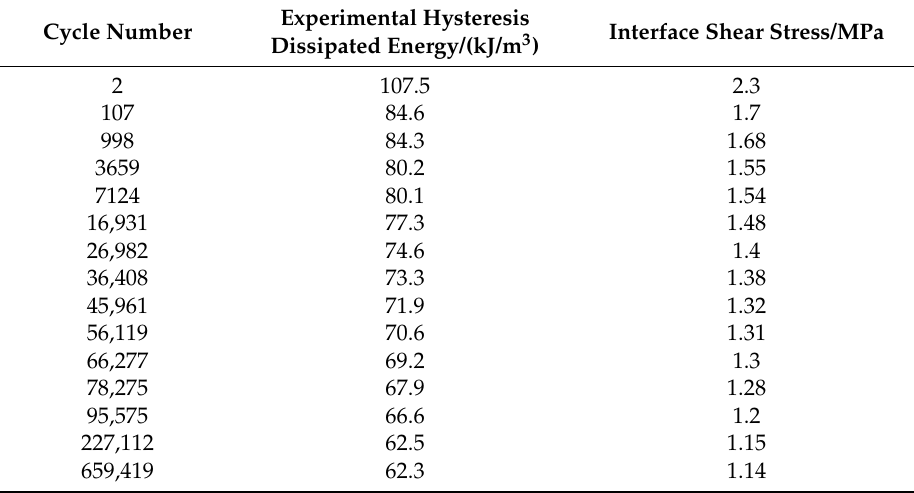
Table 3. The interface shear stress of 2D woven C/SiC composite corresponding to different applied cycles under fatigue peak stress of σ max = 375 MPa at room temperature.